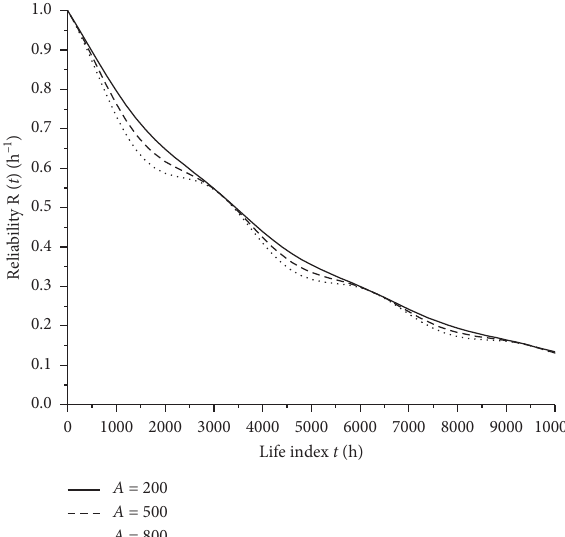
Figure 16: Effects of oscillation angular frequency on probability